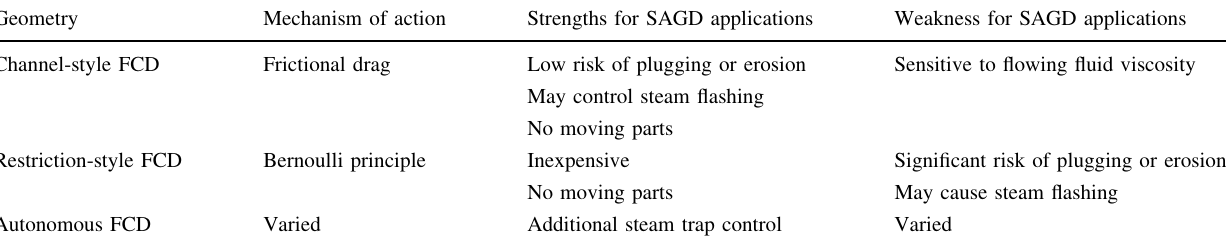
Table 1 Summary of commercially available FCD designs